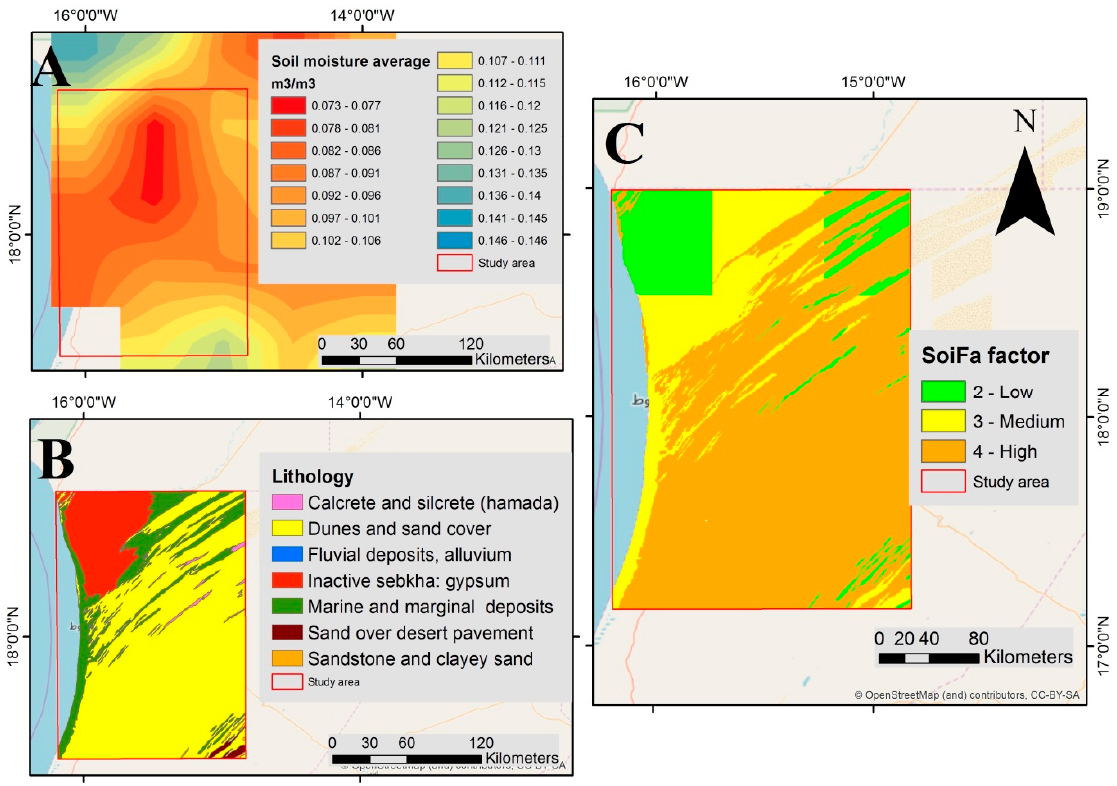
Figure 6. ( A ) Average soil moisture map, ( B ) lithological map and ( C ) soil factor map (SoiFa).